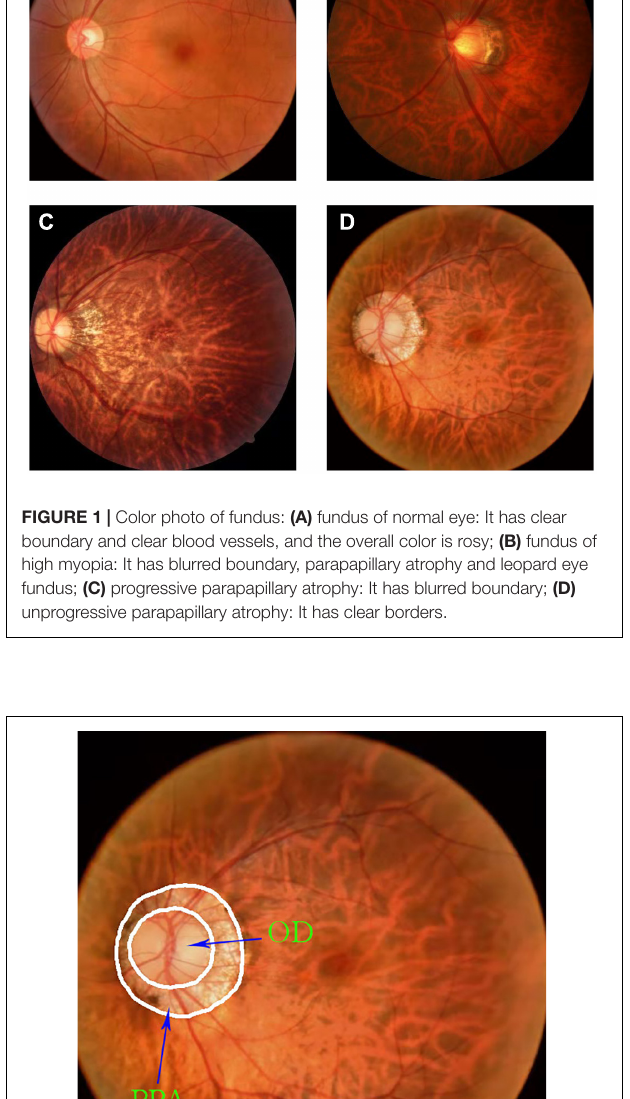
image, the grayscale fundus photos were obtained. This operation was implemented using Adobe PhotoShop 2019. Figure 3 shows truth map and PPA edge